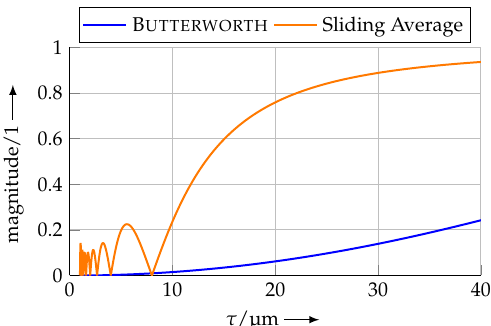
Figure 4. Frequency responses of the sliding average filter with a window length corresponding to p n = 8µm and a 2nd order B UTTERWORTH filter with a cut-off wavelength of τ c = 10 p n = 80µm. The sliding average filter offers perfect suppression of integer fractions of the window length, but lacks suppression of the wavelengths